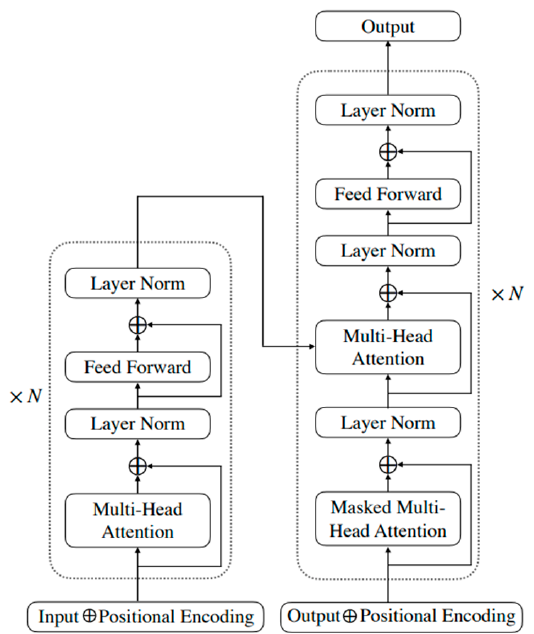
Figure 1. Schematic structure of the transformer’s architecture.